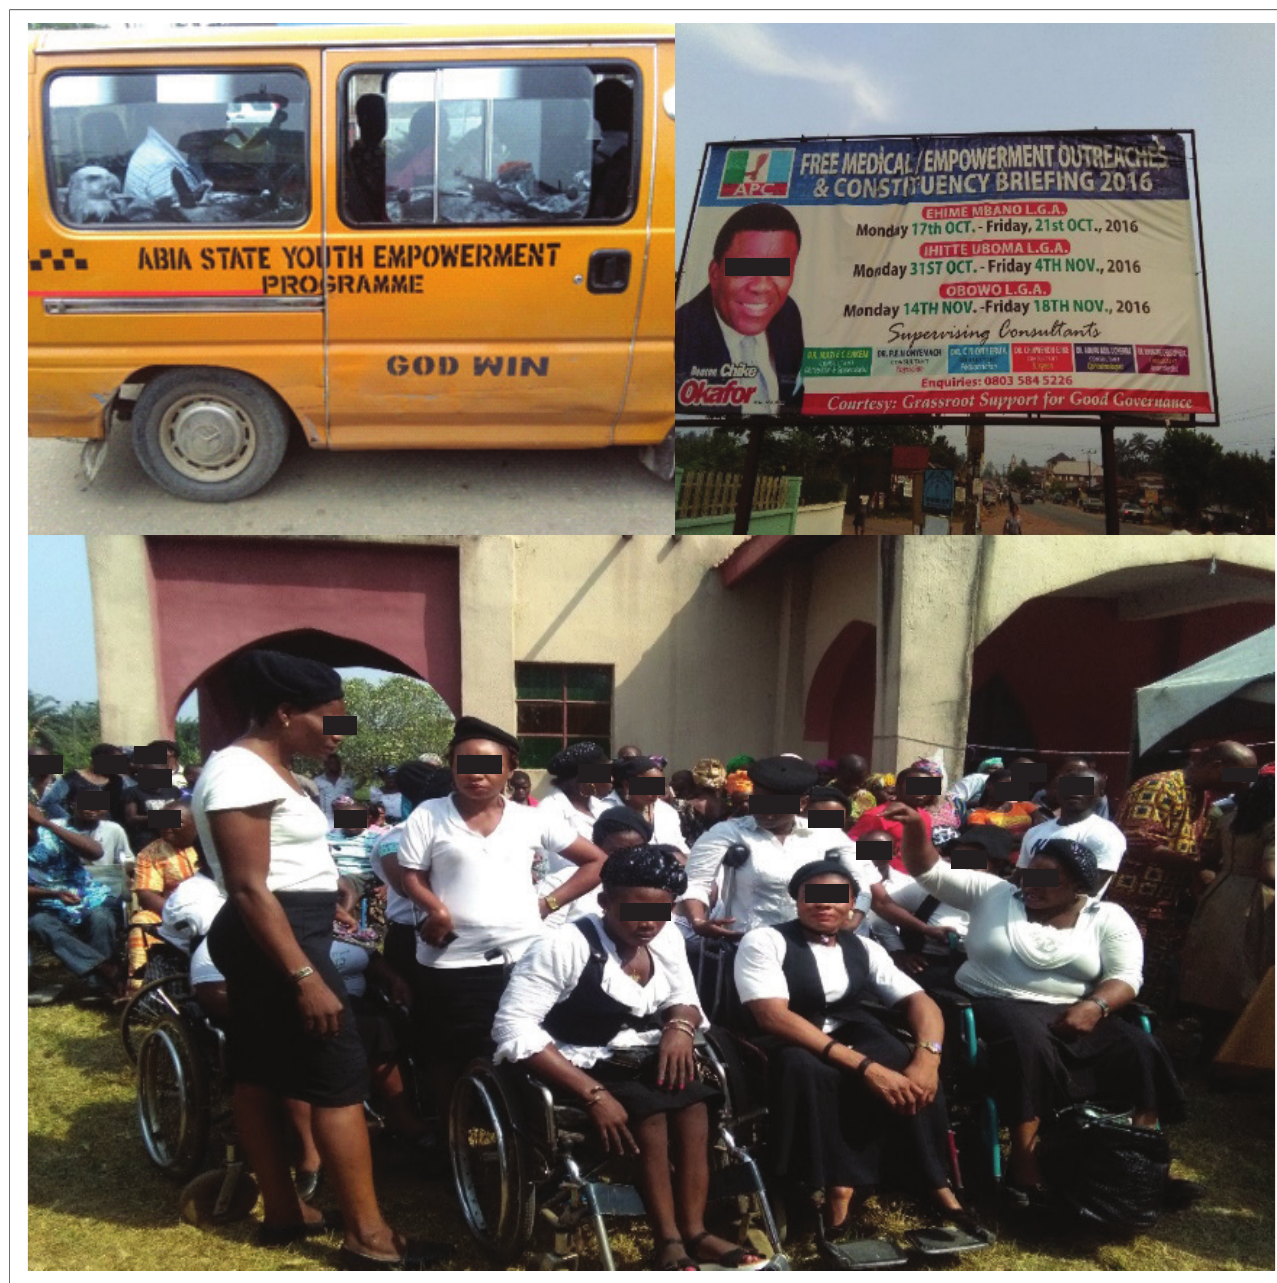
FIGURE 1: Youth, medical and private-initiative ‘empowerments’